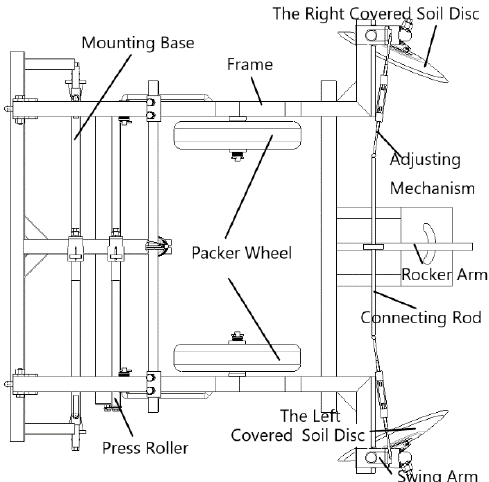
Figure 2. The structure scheme of soil covering device.